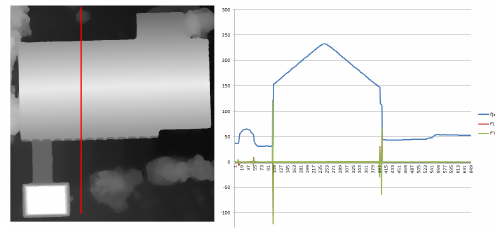
Figure 3. Roof overhang estimation from the